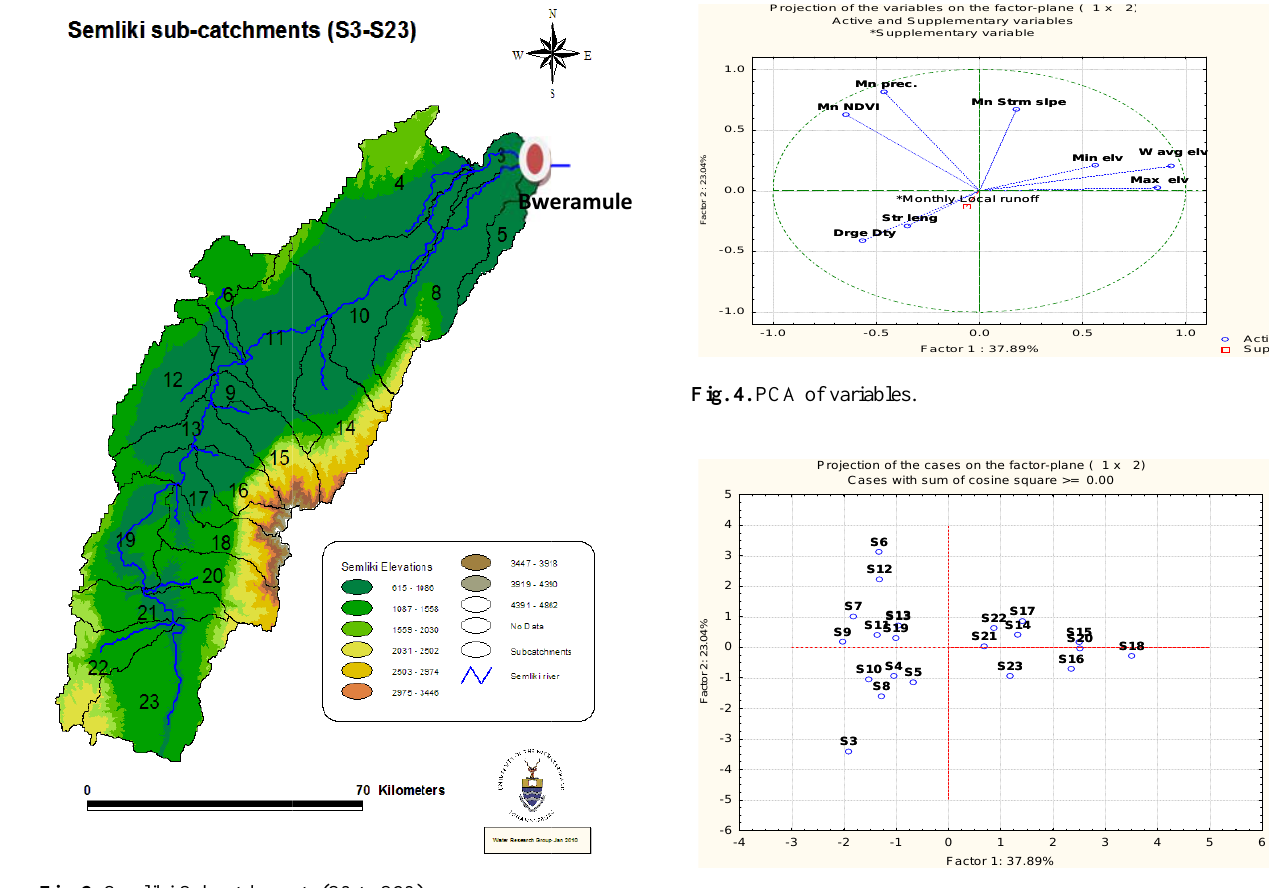
Fig. 2. Semliki Subcatchments (S3 to S23).